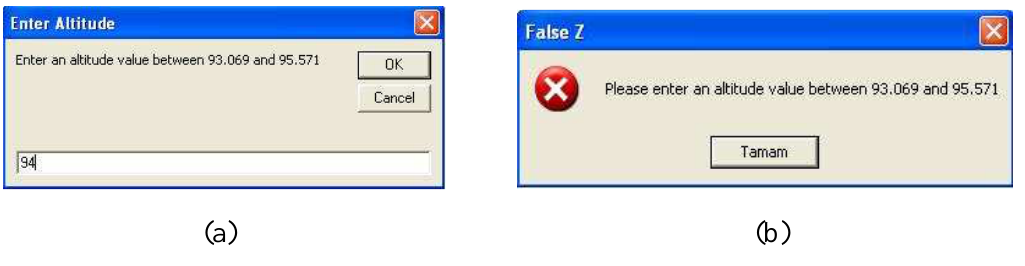
Figure 9. (a) Input box for entering Z coordinate. (b) Warning